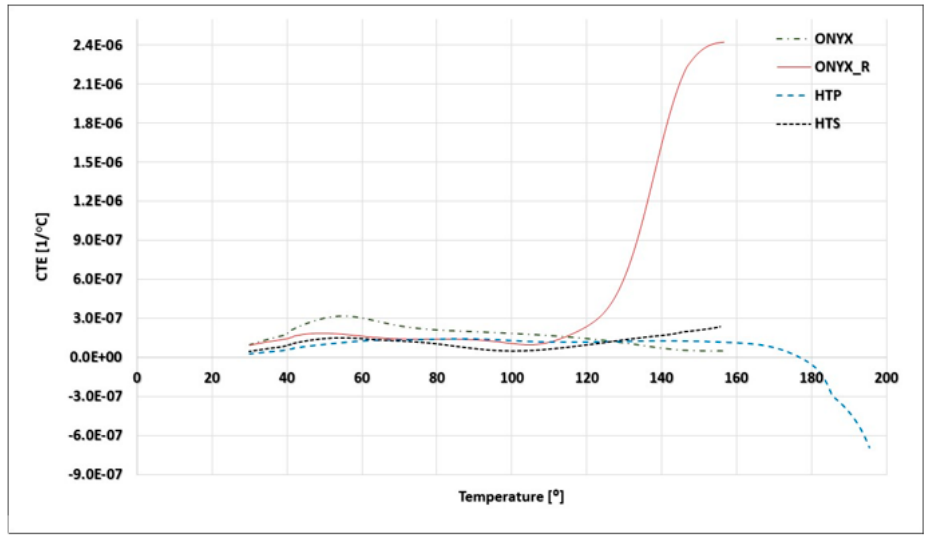
Figure 8. Thermomechanical analysis (TMA) curves showing the CTE of all investigated 3D-printed materials.